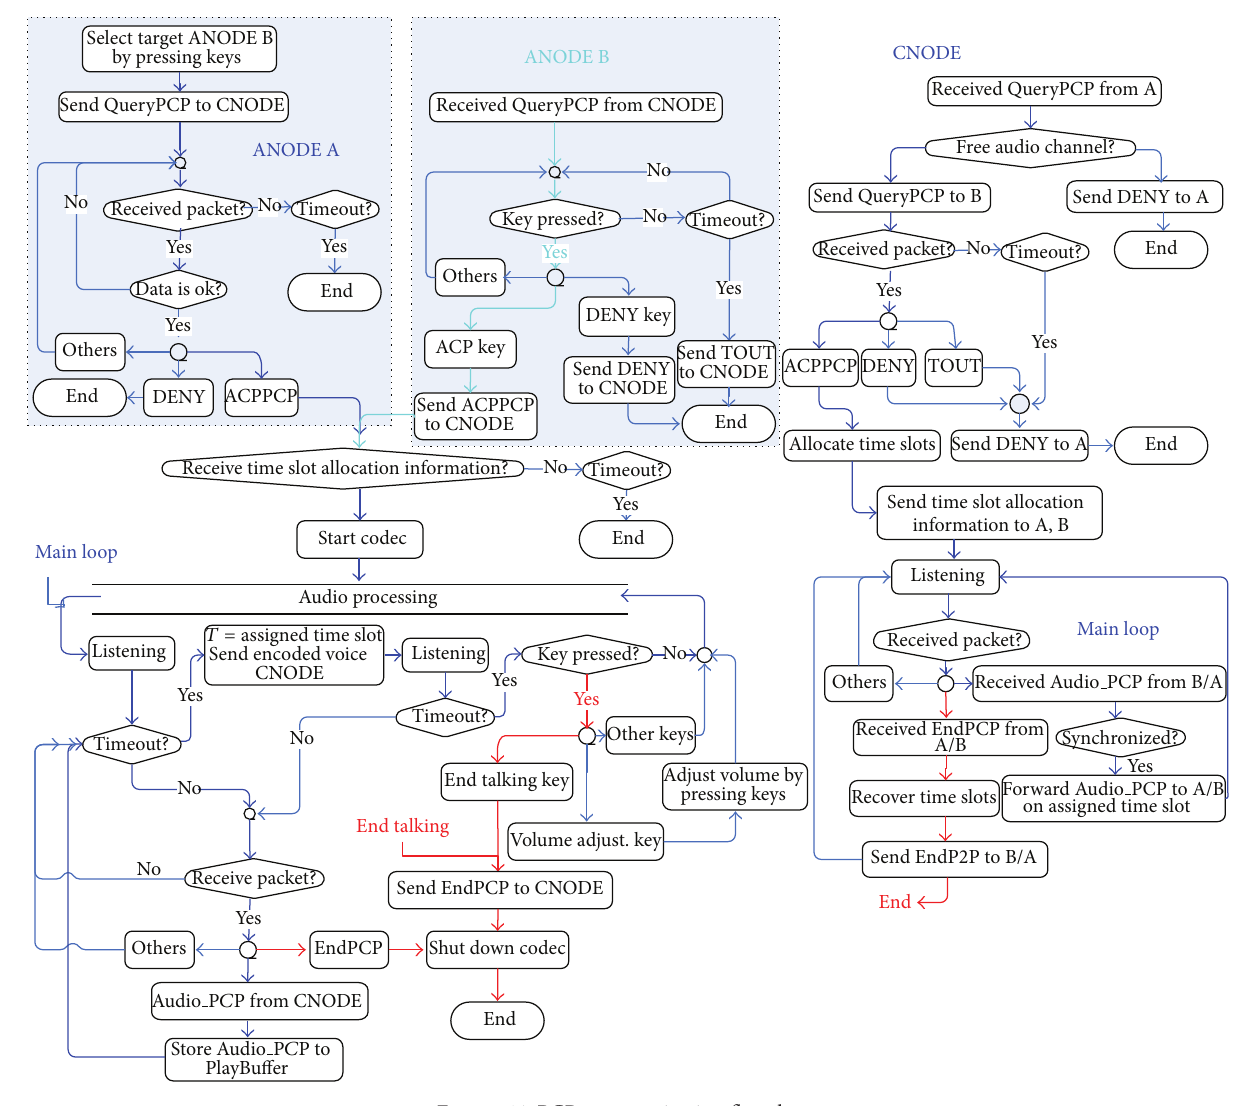
Figure 14: PCP communication